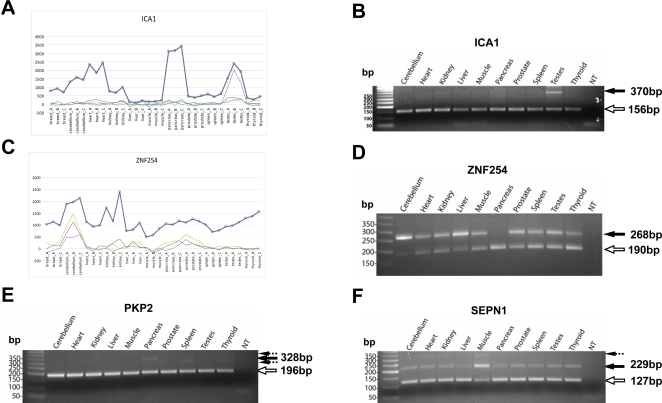
Examples of tissue-specific Alu-derived exons analyzed by Exon Array analysis, semi-quantitative RT-PCR and sequencing.A. Exon array analysis of ICA1 indicates a testes specific inclusion of Alu-derived exon. B. RT-PCR analysis of Alu-derived exon in ICA1. C. Exon array analysis of ZNF254 indicates a cerebellum specific inclusion of Alu-derived exon. D. RT-PCR analysis of Alu-derived exon in ZNF254. E. RT-PCR analysis of Alu-derived exon in PKP2. F. RT-PCR analysis of Alu-derived exon in SEPN1. In Exon Array analysis, the bold line represents the overall gene expression levels across all 11 tissues, each with 3 replicates; each of the fine lines represents the background corrected intensities of a probe targeting the Alu-derived exon. In each gel figure, solid arrows show sequencing analysis confirmed Alu exon inclusion forms. Hollow arrows show sequencing analysis confirmed Alu exon skipping forms. Dashed arrows show sequencing analysis confirmed non-specific PCR products.